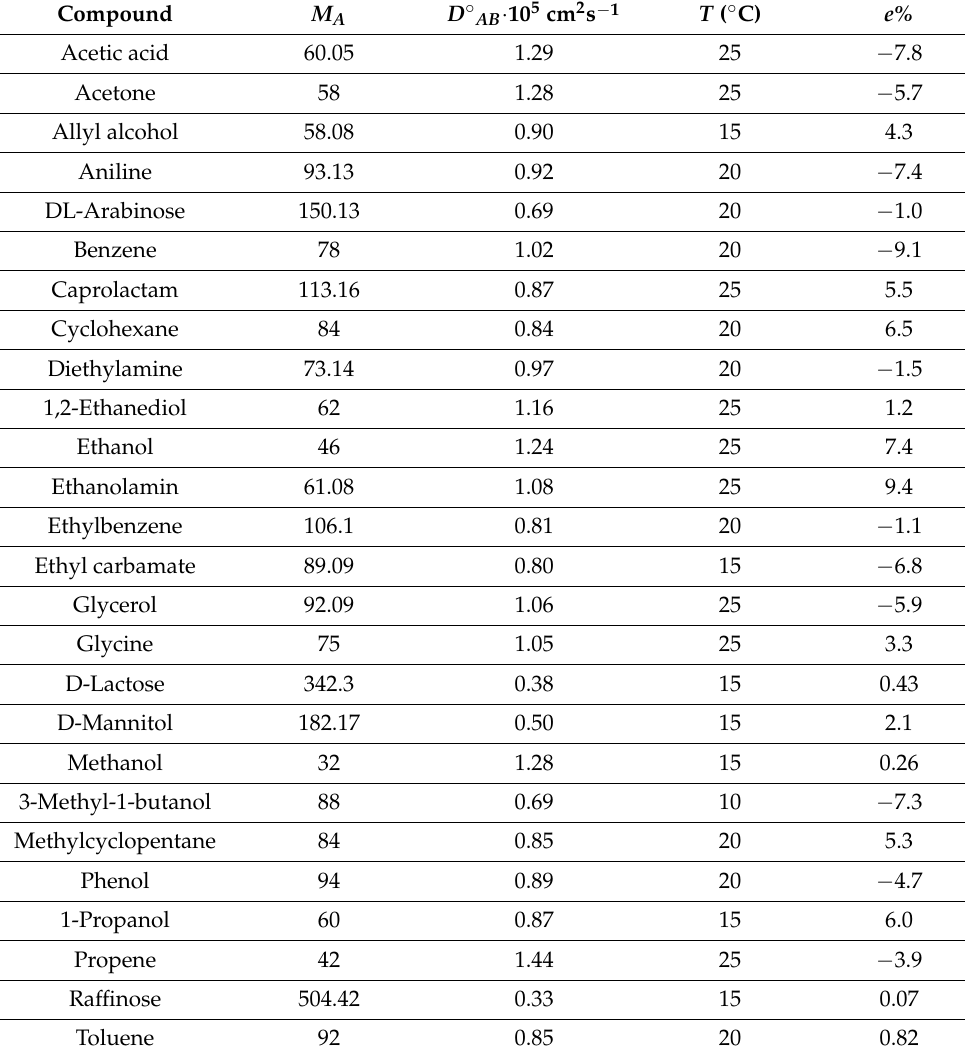
Table 5. D ◦ AB -values in water. Compounds with relative molecular mass M A , experimental D ◦ AB - values [10] at temperature T , and percent errors of the predicted D ◦ AB